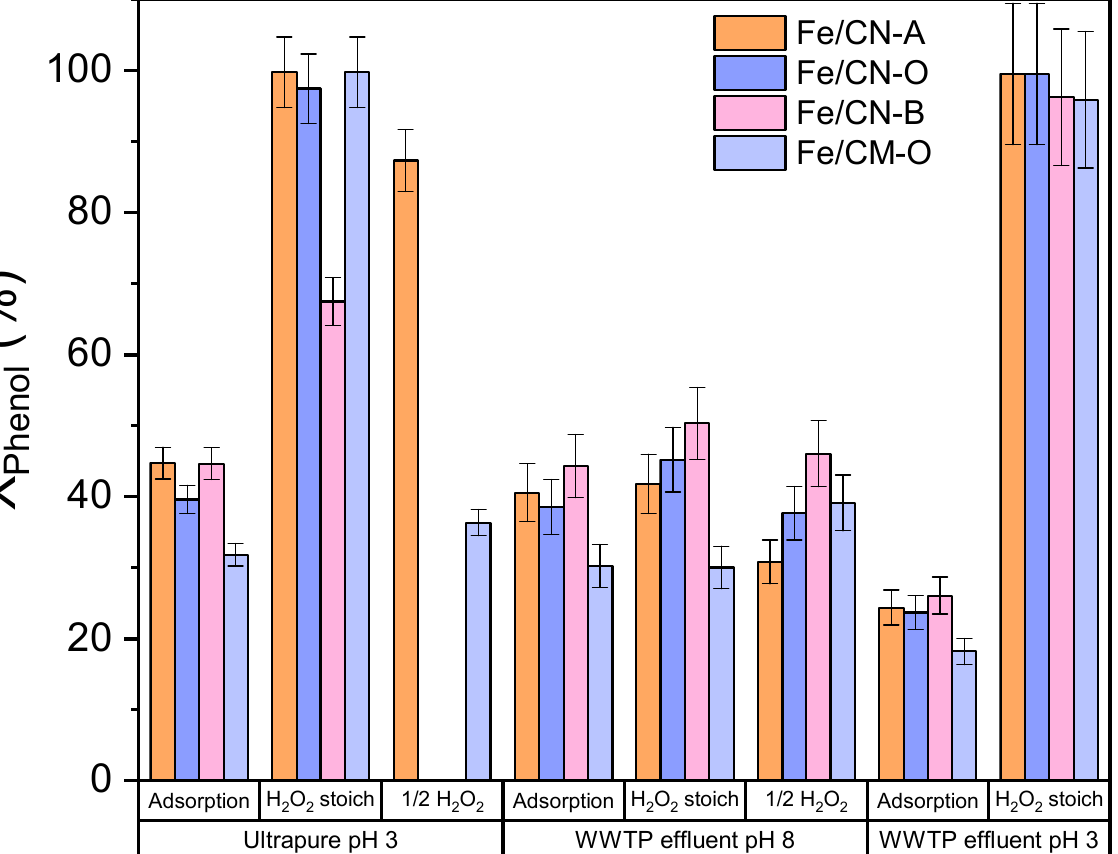
Figure 7. Effect of water matrix and pH of the reaction medium in the phenol removal by CWPO reaction (240 min). Reaction conditions: 50 mL reaction volume, 500 mg·L − 1 catalyst, 500/250 mg·L − 1 H 2 O 2 , 200 rpm, 50°C, 240 min reaction